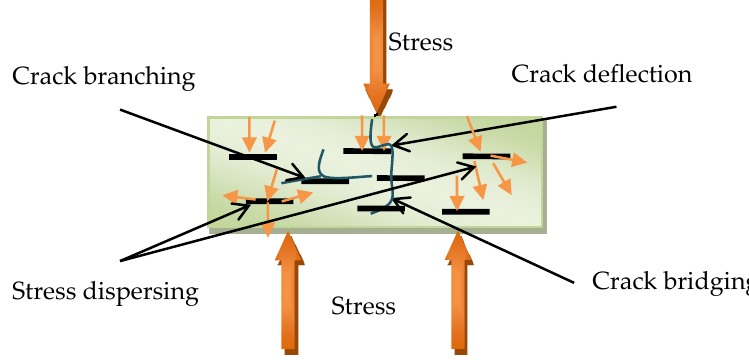
Figure 12. Scheme of GNP–cement composite under bending load.